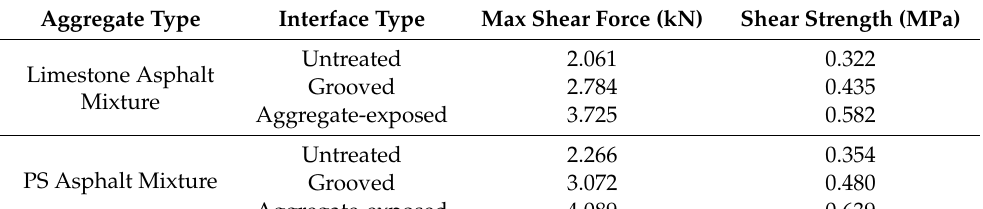
Table 3. Impact of aggregate and interlayer treatment on the interlaminar bonding.